Question: In one sentence, what is this figure communicating?
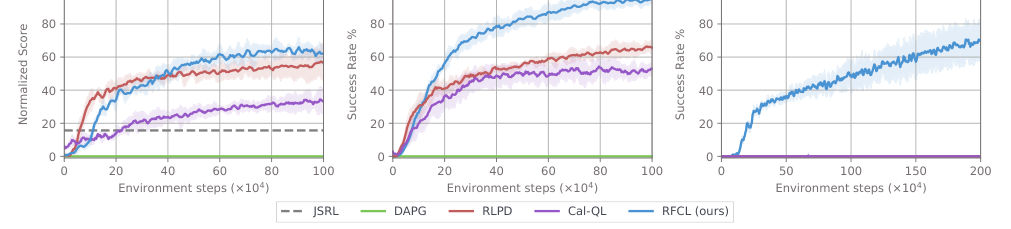
Answer: Mean success rate of algorithms for each environment suite across all tasks after 1M interaction steps with 5 demonstrations. Results are averaged within environment. Shaded areas represent 95% CIs over 5 seeds. The result show RFCL is significantly more performant and sample efficient compared to baselines. Note that RLPD and JSRL can normally achieve decent results but require many more demonstrations for harder tasks.